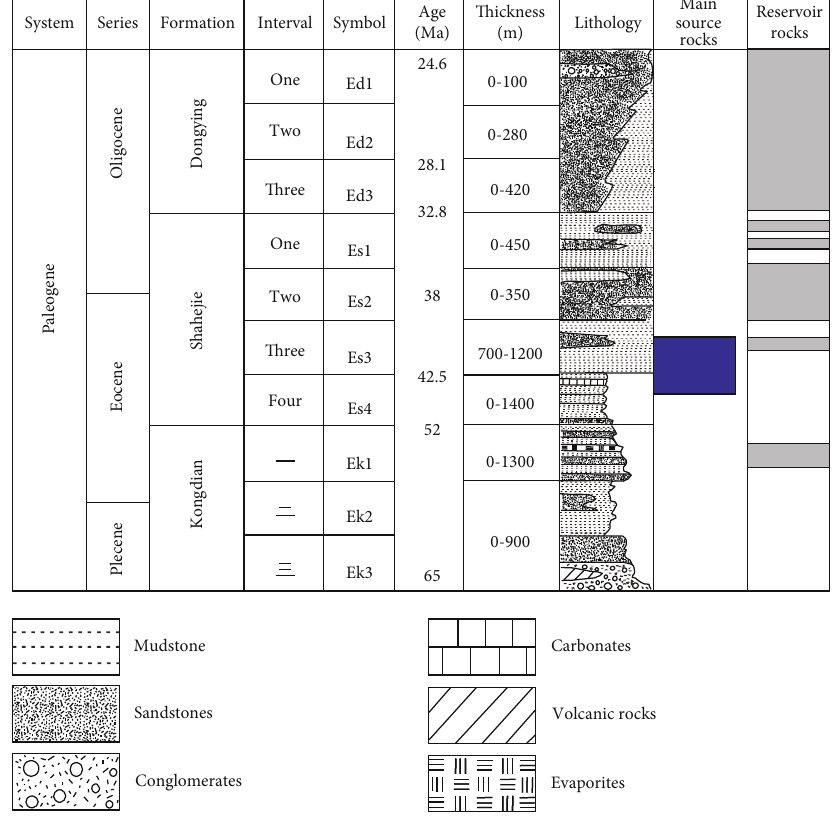
Figure 2: Comprehensive histogram of Cenozoic strata in Dongying sag and sampling depths indicated by the blue rectangle (modi fi ed from